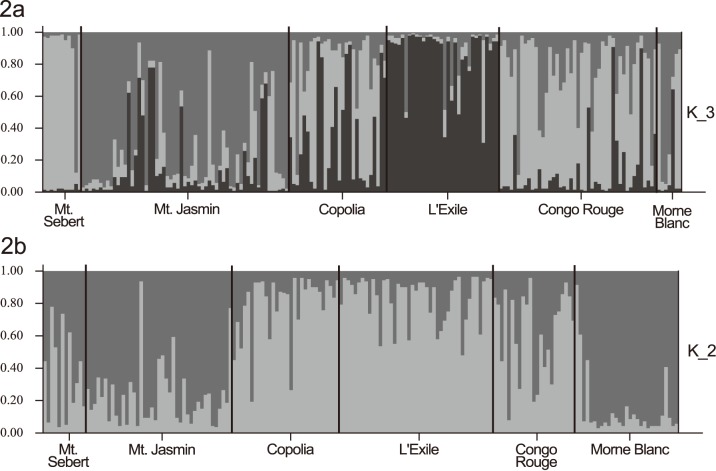
Bayesian structure analysis of Glionnetia sericea with the STRUCTURE software.Bars represent individual G. sericea adult individuals with their assignment proportions (y axis) to the different clusters/genetic groups. Performing the analysis for K_3 (three different grey shades), representing three genetic clusters (a). STRUCTURE analysis for G. serivea juveniles, performing the analysis for K_2 (two different grey shades), representing two genetic clusters (b).